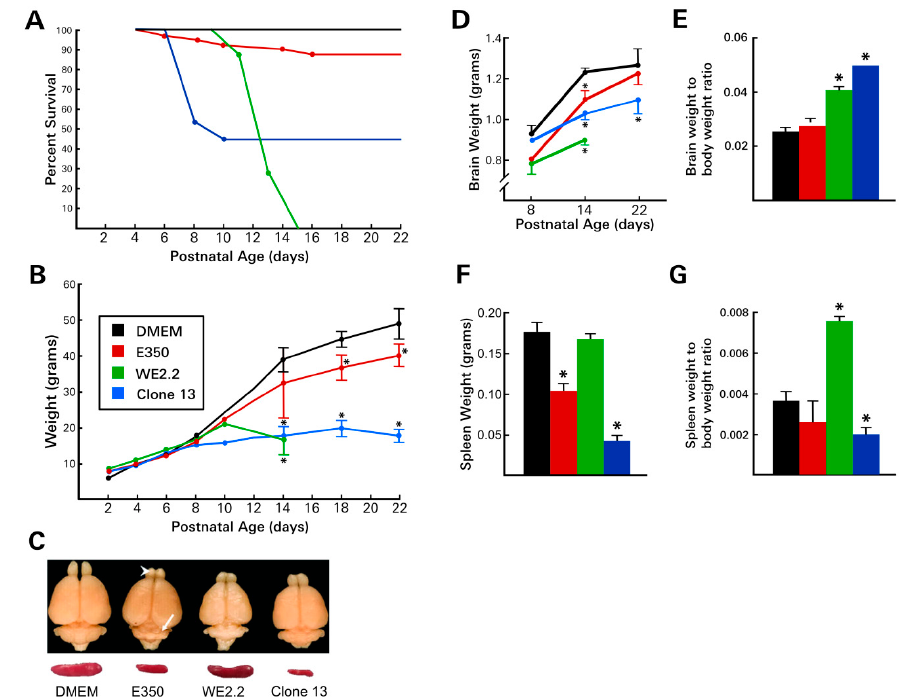
Figure 2. The different LCMV strains induced different diseases . ( A ) Following intracerebral inoculation on PD4, the various strains of LCMV induced markedly different patterns of mortality. The WE2.2 strain caused mortality starting on PD10, and all infected animals were dead by PD15. In contrast, the E350 strain caused very little mortality, and none after PD16. Clone 13 caused high rates of mortality during PD6-PD10, but no mortality at later time points. ( B ) Body weight deficits differed among the strains. The E350 strain caused only mild growth deficits. In contrast, Clone 13 and WE2.2 induced profound growth failure. ( C ) Representative brains and spleens at PD14 from each treatment group. All strains induced microencephaly, but the severity differed among strains. Focal destructive lesions in the olfactory bulb (arrowhead) and cerebellum (arrow) occurred only with the E350 strain. E350 and Clone 13 reduced spleen size, while WE2.2 did not. ( D ) Brain weights were reduced by all three strains, but most substantially by WE2.2. ( E ) Despite the microencephaly, brain weight-to-body weight ratios were increased in animals infected with WE2.2 and Clone 13 because of the greater impairment of body growth, compared to brain growth. ( F ) Spleen weights were substantially reduced by infection with E350 and Clone 13, but not by WE2.2. ( G ) Ratios of spleen weight to body weight were differentially affected by the viral strains due to different degrees of microsplenia and body growth. All data points represent means and error bars represent standard error of the mean. * Significantly different from uninfected control (Dulbecco’s Modified Eagle Medium (DMEM) injected animals.